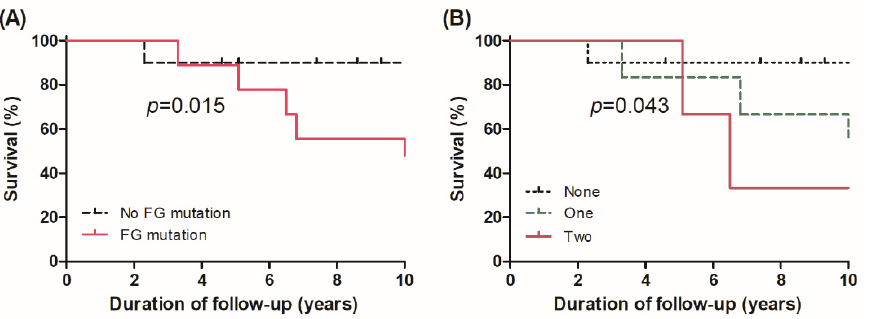
Figure 4. Overall survival curve in patients with classic PTC according to ( A ) presence of mutation in functional groups and ( B ) the number of mutation sites in functional groups.